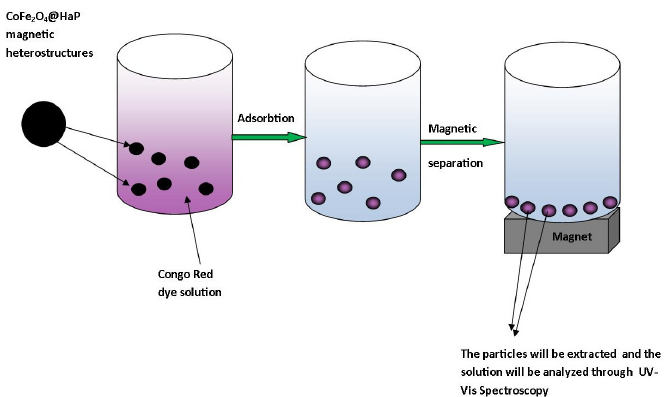
Figure 2. The general diagram of the Congo Red dye removal process .